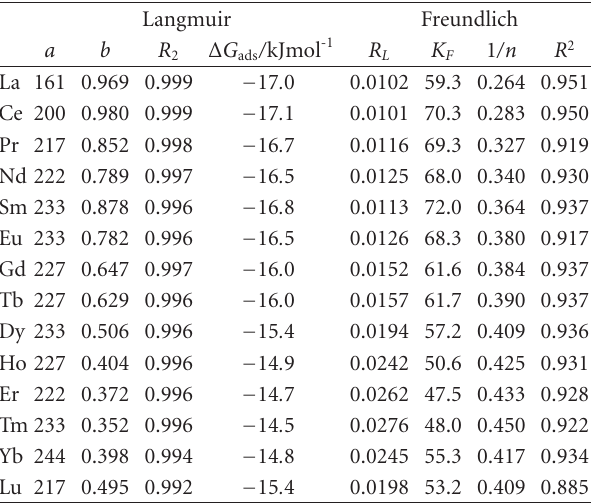
Table 6: Coe ffi cient of Langmuir and Freundlich isotherms for lanthanides using Buccinum tenuissimum shell biomass after heat- treatment (950 ◦ C , 6 hours) and adding water. Langmuir